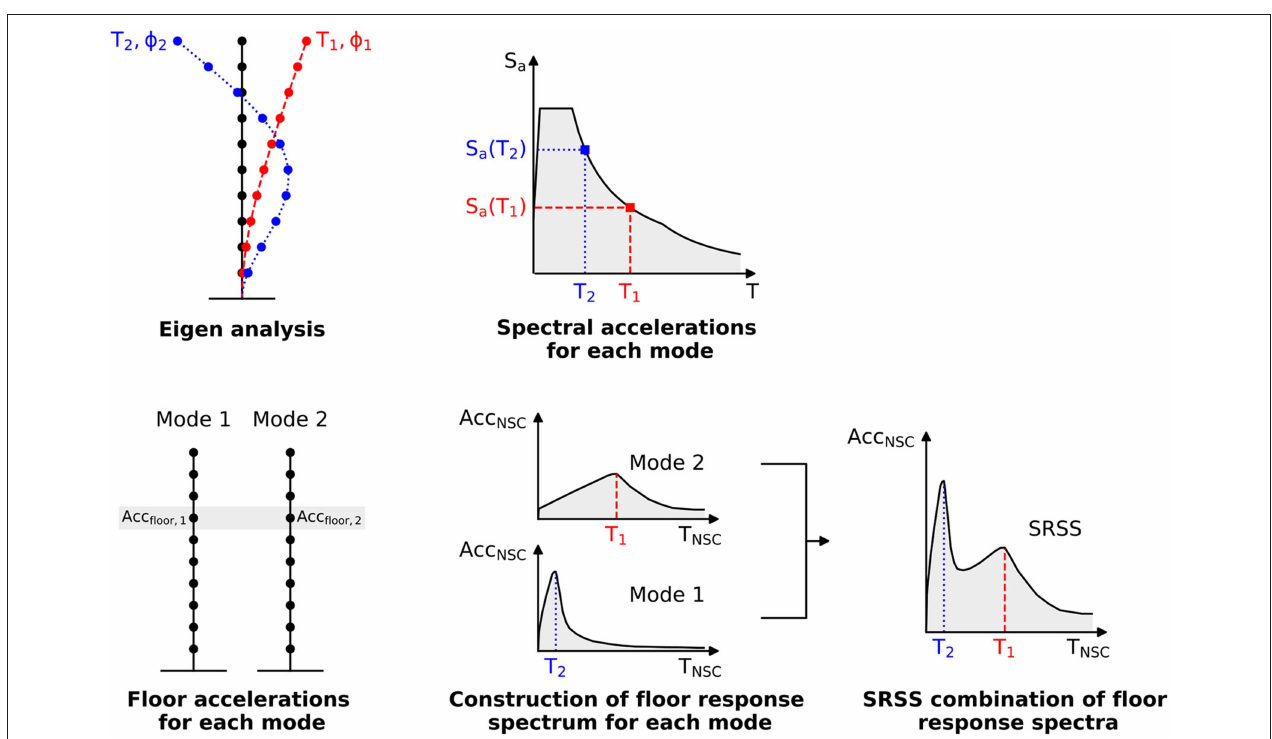
FIGURE 1 | Modal superposition methodology for the computation of floor acceleration demands (adapted from Sullivan and Calvi,